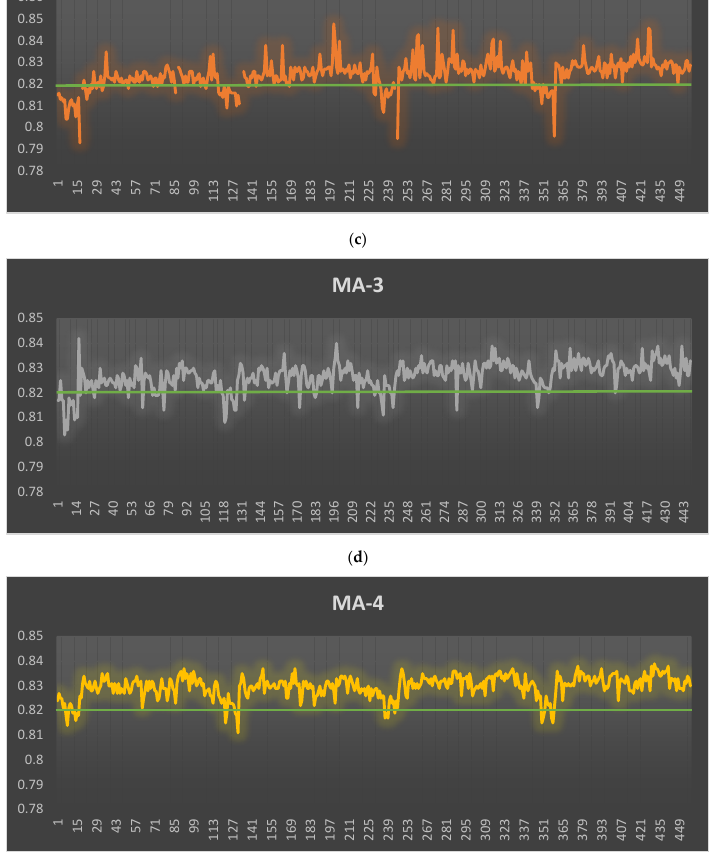
Figure 4. Initial state-run chart of storage volume on machines ( a ) MA whole line, ( b ) MA-1, ( c ) MA-2, ( d ) MA-3, and ( e ) MA-4.